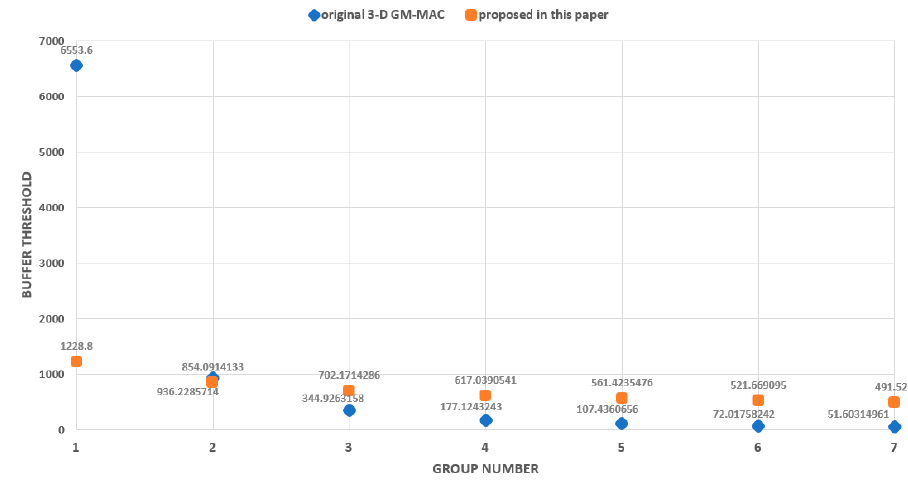
Table 4. Simulation environment of 3-D